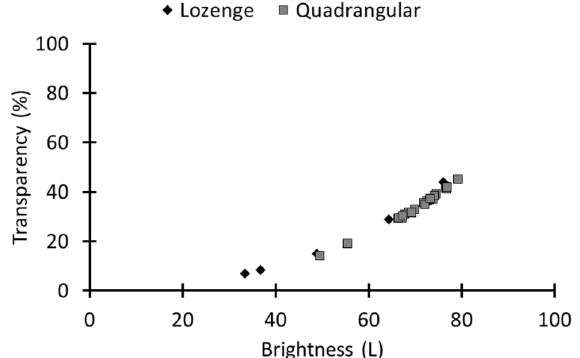
Figure 4. The transparency and brightness (L colour coordinate) values calculated from the simulated light transmission spectra with fixed thickness (3 mm for lozenge and 2 mm for quadrangular) show a higher light transmission for the later-dated quadrangular window glass.